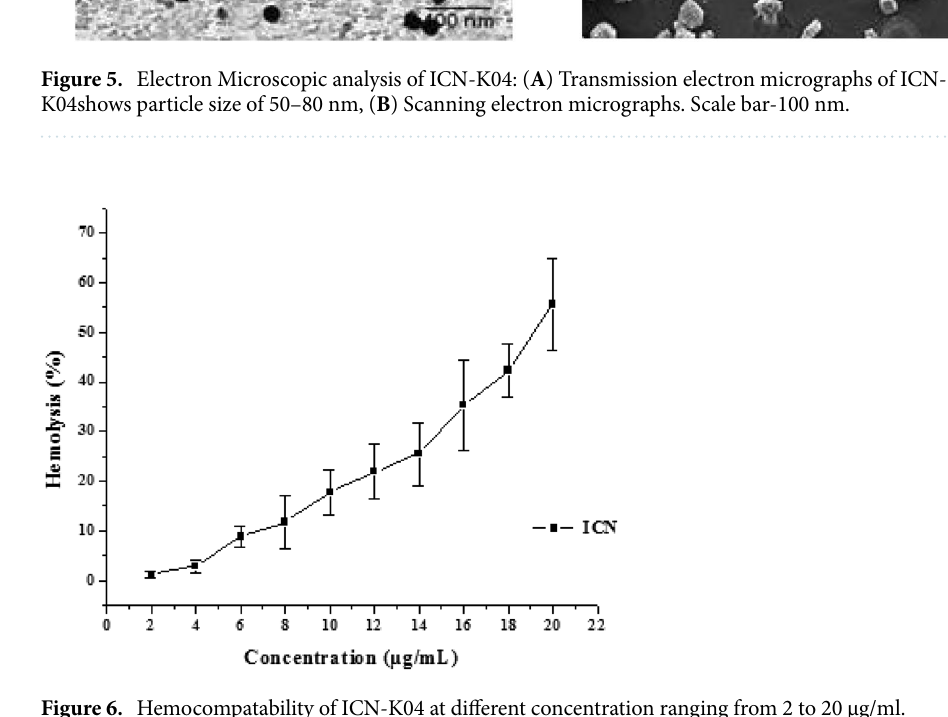
Figure 6. Hemocompatability of ICN-K04 at different concentration ranging from 2 to 20 μg/ml.